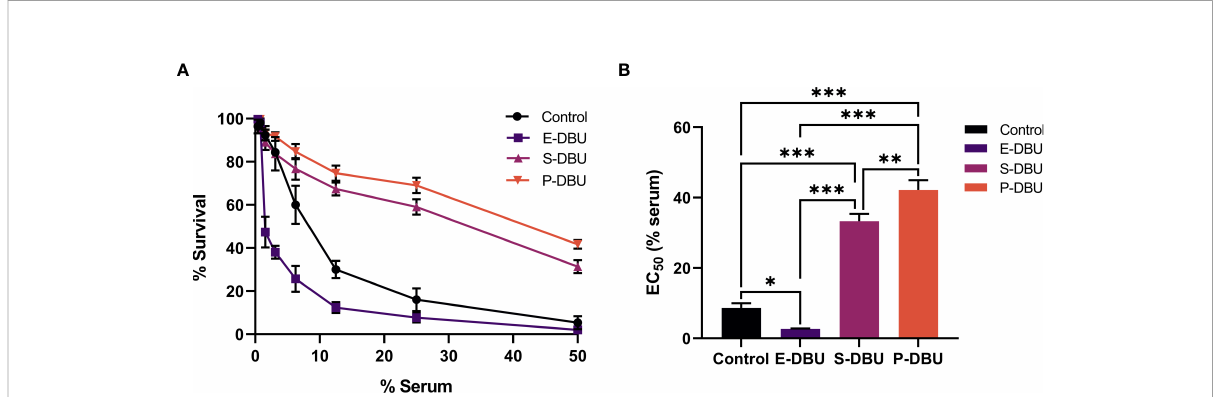
FIGURE 3 Dose-dependent sensitivity to complement-mediated lysis. (A) Percentage survival of exponential phase promastigotes (E-DBU), stationary phase promastigotes (S-DBU), and PNA non-agglutinated promastigotes (P-DBU) cultured in SIM, pH 5.0 with DBU and 10% (v/v) FBS, and stationary phase promastigotes cultured in SIM, pH 7.0 (control) after being exposed to two-fold serially diluted human serum. (B) The EC 50 value of E-DBU, S-DBU, and P-DBU promastigotes cultured in SIM, pH 5.0 with DBU and 10% (v/v) FBS and promastigotes cultured in SIM, pH 7.0 (control). Statistically signi fi cant differences between groups are indicated as follows: * P < 0.1; ** P < 0.01; *** P < 0.001.